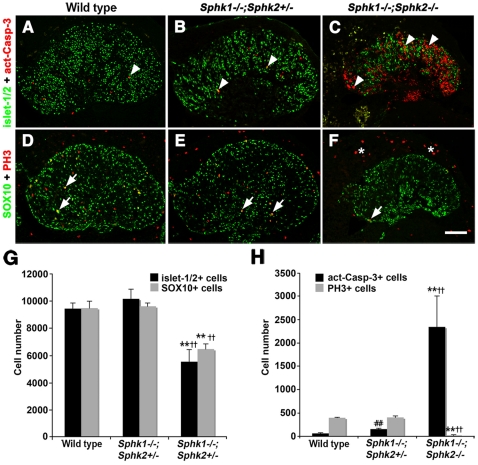
Cell loss is further exacerbated in E11.5 Sphk1−/−;Sphk2−/− trigeminal ganglion.(A–C) E11.5 (40–42 somites) trigeminal ganglia from wild type, Sphk1−/−;Sphk2+/−, and Sphk1−/−;Sphk2−/− were immunostained with antibodies to act-Casp-3 (red, arrowhead) and islet-1/2 (green, nuclear). A small number of act-Casp-3+ cells can be seen in wild type and Sphk1−/−;Sphk2+/− ganglia; in contrast, there are many more act-Casp-3+ cells in Sphk1−/−;Sphk2−/− trigeminal ganglion. (D–F) Adjacent sections to those in (A–C) were immunostained with antibodies to PH3 (red, arrow) and SOX10 (green, nuclear). PH3+ cells are scattered throughout the trigeminal ganglia from wild type (D) and Sphk1−/−;Sphk2+/− (E) embryos. (F) There are very few PH3+ cells in the Sphk1−/−;Sphk2−/− trigeminal ganglia; normal number of PH3+ cells outside the trigeminal ganglion were detected in the double mutant (asterisks). (G) Quantification of total cell number shows that the number of neurons (islet-1/2+) and progenitor cells (SOX10+) are similar in the wild type and Sphk1−/−;Sphk2+/− at E11.5. There are significant decreases in neurons and progenitor cells in Sphk1−/−;Sphk2−/− double mutant ganglia. n = 3 embryos from each genotype; ** = Sphk1−/−;Sphk2−/− to wild type comparison, p<0.01. †† = Sphk1−/−;Sphk2−/− to Sphk1−/−;Sphk2+/− comparison, p<0.01. (H) Compare to wild type, the increase of act-Casp-3+ dying cells is small and represents less than 1% of the total cell population in the Sphk1−/−;Sphk2+/− trigeminal ganglia, the number of dying cells increases to 2,343, almost 20% of the total cells in Sphk1−/−;Sphk2−/− double mutant trigeminal ganglia. We observe significant decrease of PH3+ dividing cells in the double mutant compare to wild type and Sphk1−/−;Sphk2+/− trigeminal ganglia at this stage. ** = Sphk1−/−;Sphk2−/− to wild type comparison, p<0.01. †† = Sphk1−/−;Sphk2−/− to Sphk1−/−;Sphk2+/− comparison, p<0.01; ## = Sphk1−/−;Sphk2+/− to wild type comparison, p<0.01. Scalebar for A–F = 100 µm.